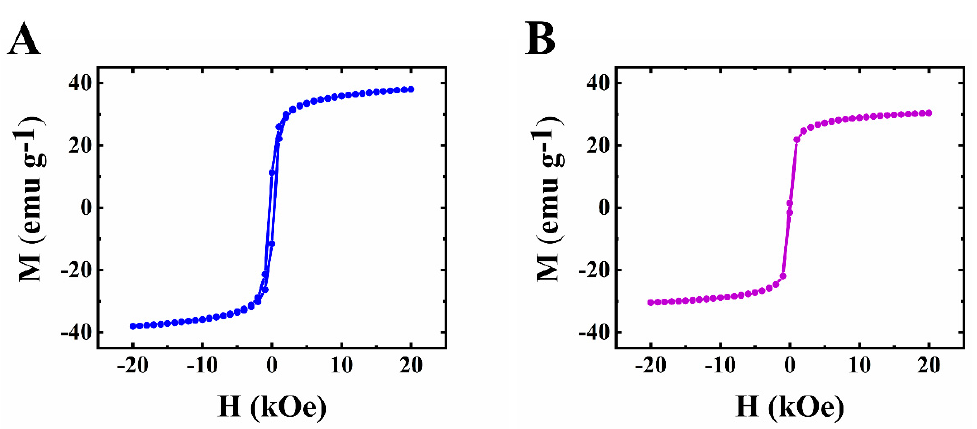
Figure 1. Magnetization (M) versus magnetic field (H) for CuFe 2 O 4 at ( A ) 5 K and ( B ) 293 K.